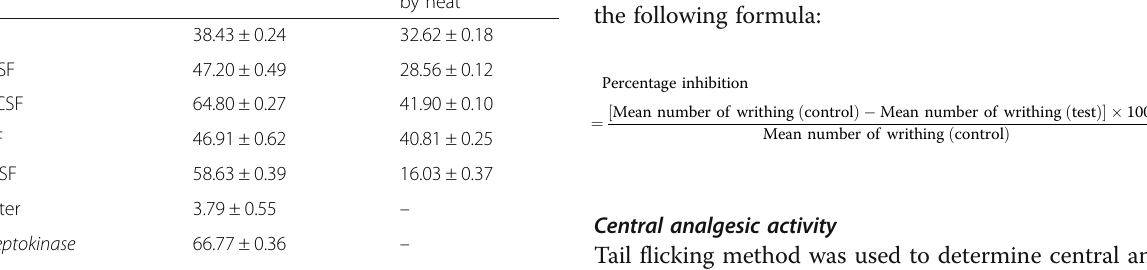
intraperitonially. After giving a resting period of 10 min, the number of writhing given by each animal was counted for the next 10 min. The percent inhibition of pain induced by acetic acid was calculated according to the following formula: